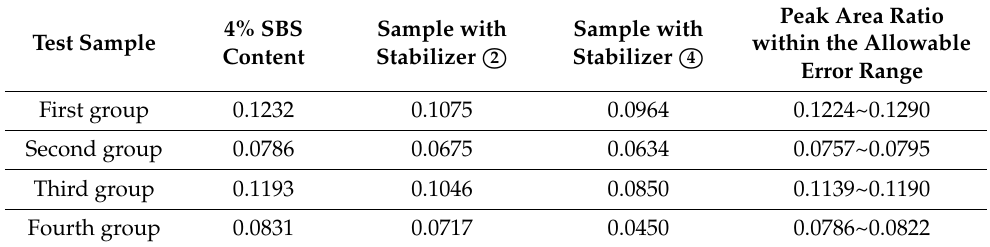
Table 7. Test result of peak area ratio.